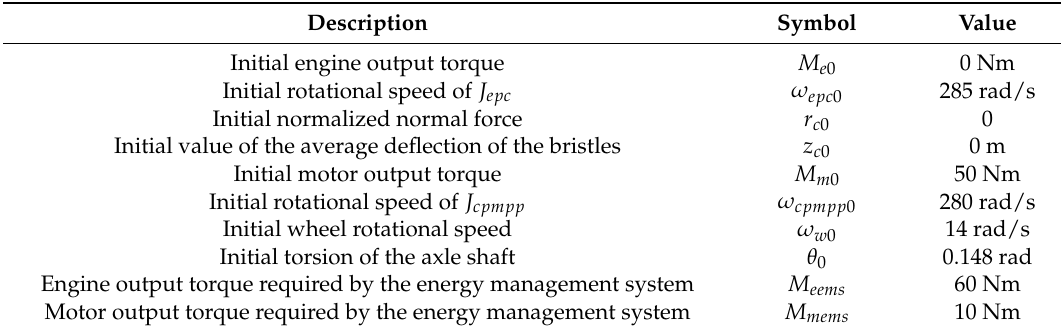
Table 4. Initial values of the relevant